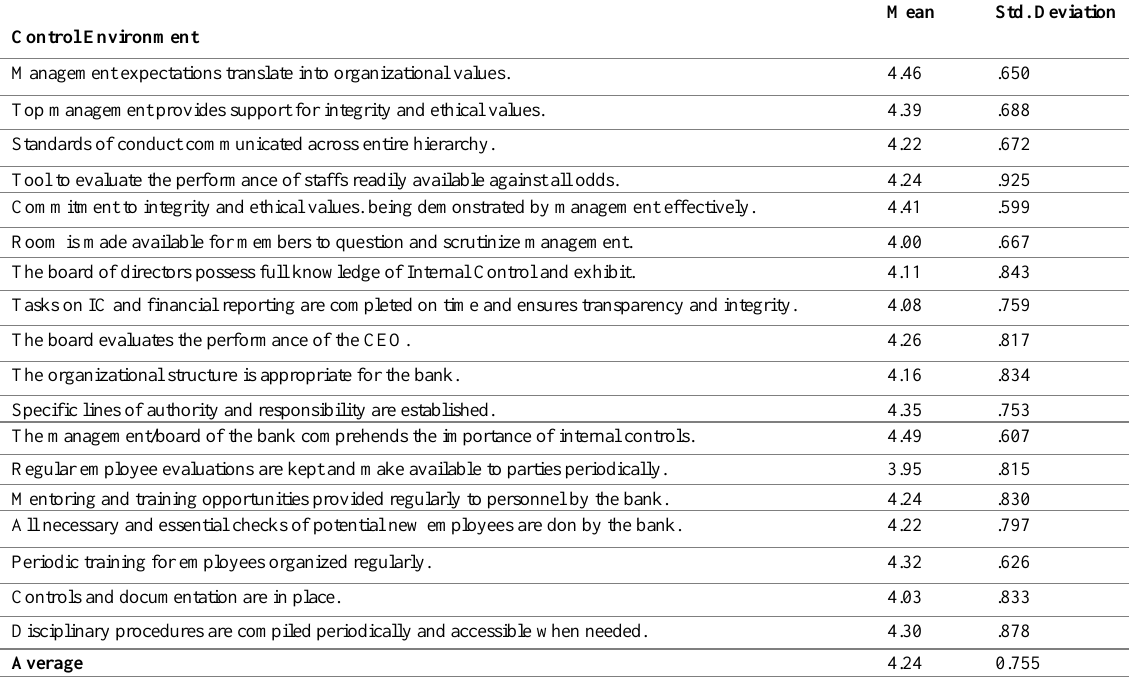
Table 4: Means, standard deviation for Control environment Component of COSO